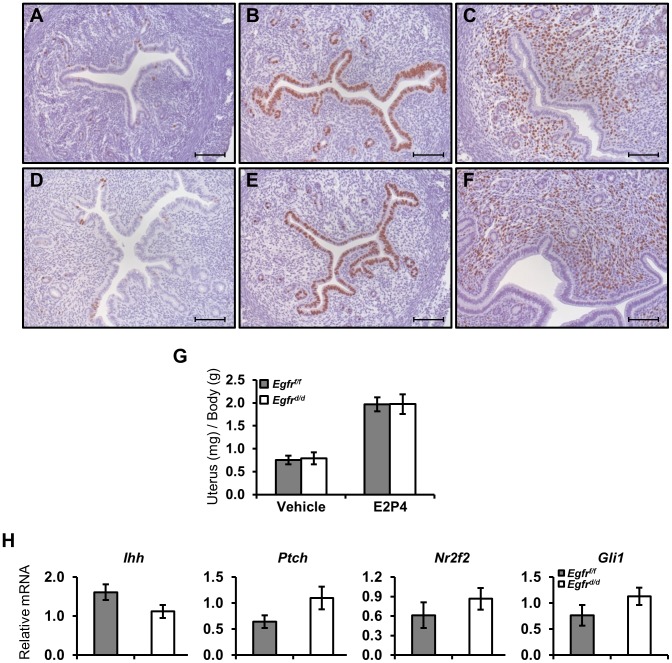
Ablation of Egfr does not alter delayed pregnancy proliferation or preimplantation markers.Mice were ovariectomized and treated with exogenous hormones to mimic various stages of preimplantation biology. (A–F) Measurement of proliferation by BrdU immunohistochemistry in (A–C) Egfrf/f or (D–F) Egfrd/d mice primed with estrogen and then treated with (A,D) vehicle, (B,E) estrogen or (C,F) estrogen (50 ng) and progesterone for 15 hours. Scale bars: 100 µm. (G,H) Mice were treated with 3 days of estrogen (100 ng), given 2 days rest and then treated for 2 days with estrogen (6.7 ng) and progesterone (1 mg) to mimic day 3.5 of pregnancy. (G) Measurement of uterine wet weights after oil or hormone treatment. (H) qPCR measurement of known preimplantation regulators.